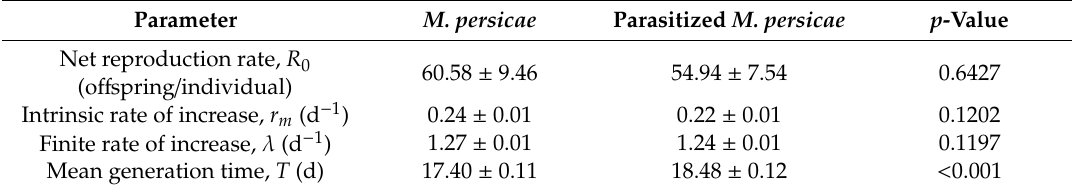
Table 2. Population parameters (means ± SE) of Aphidoletes aphidimyza fed on unparasitized and parasitized Myzus persicae by Aphidius gifuensis.